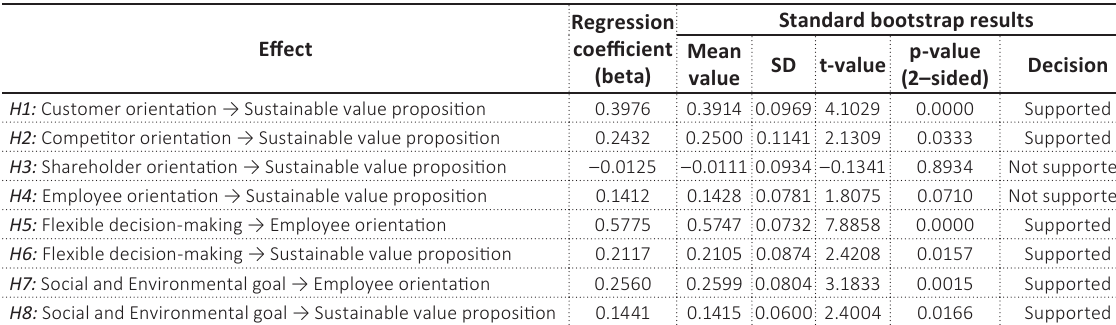
Table 5. Analysis of hypothetical